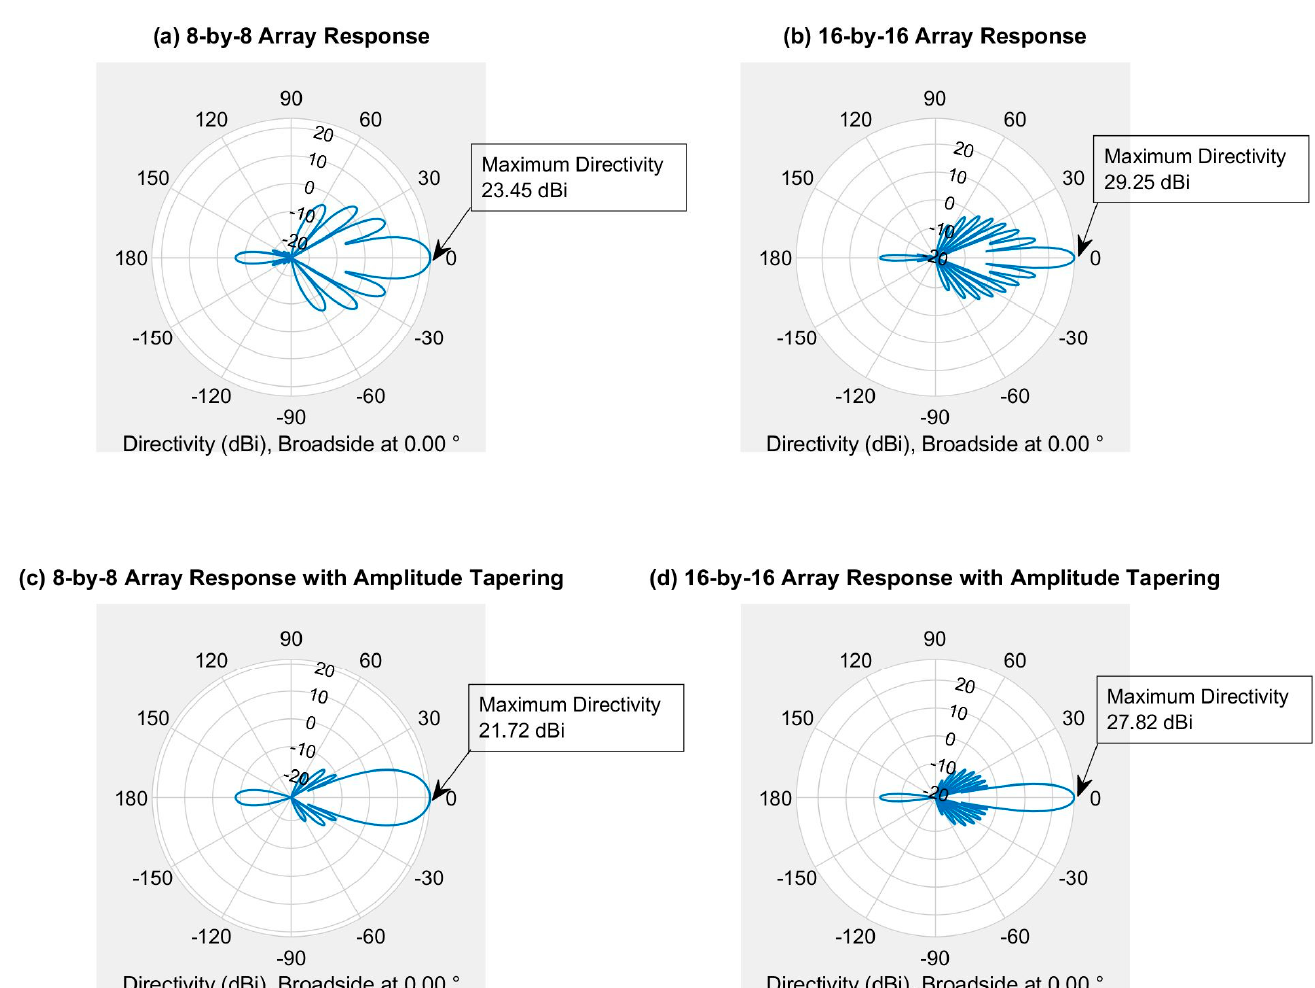
Figure 11. 2D radiation pattern of the array (i.e., 8-by-8 and 16-by-16 array) with and without amplitude tapering.